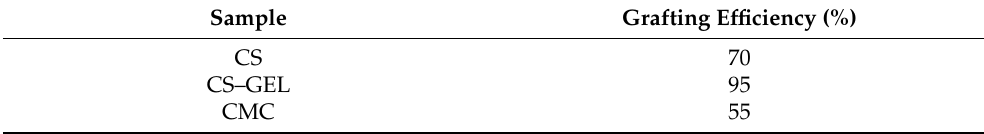
Table 1. Estimation of the phenolics bound onto the enzymatically modified CS, CS–GEL and CMC membranes according to the Folin–Ciocalteu method. (The standard deviation was less than 5% in all cases.)